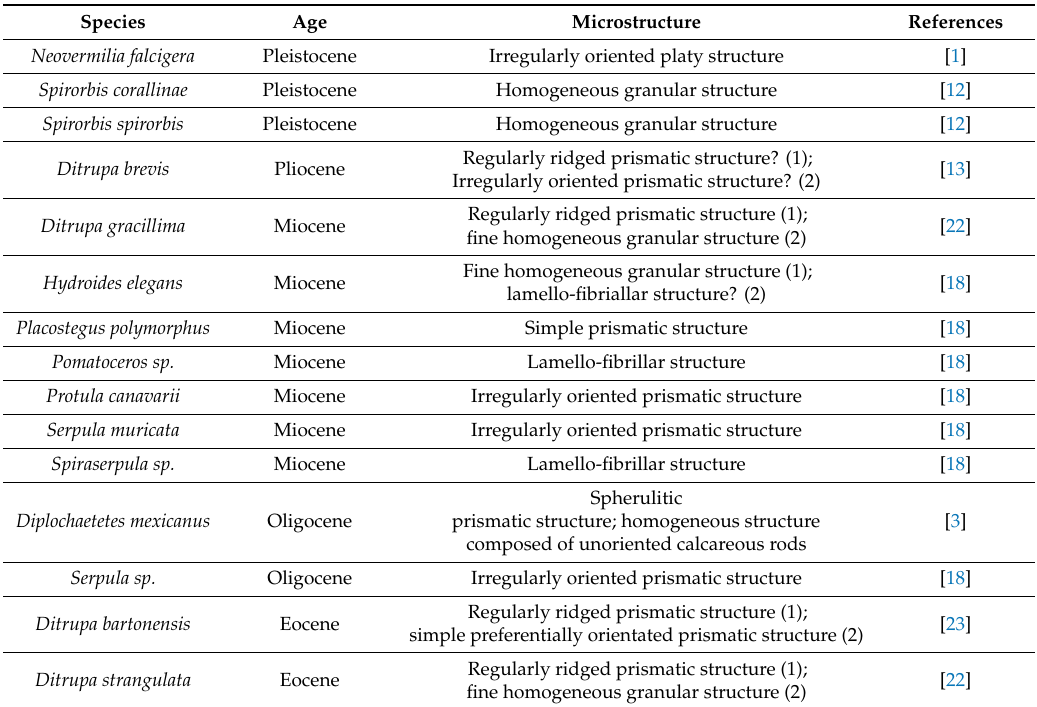
Table 1. Microstructures of fossil calcareous